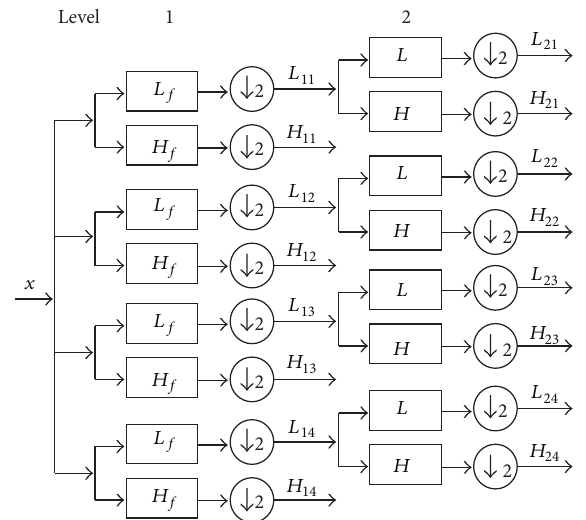
Figure1:Twolevelsof2Dcomplexdouble-densitydual-treewavelet